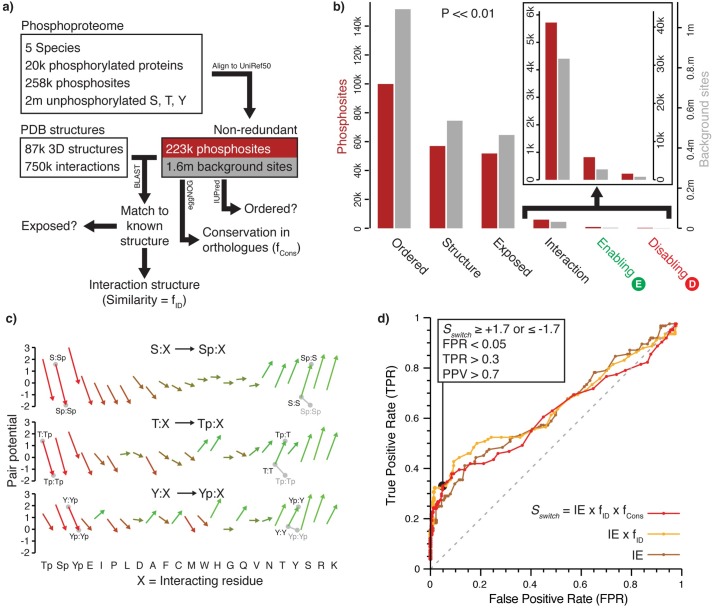
Summary of the data processing pipeline and results.a) Source data and processing steps. b) Summary of counts of phosphosites (red bars, left-hand y-axis) and background sites (grey bars, right-hand y-axis) that are ordered, matched to a template structure, were surface exposed, in an interaction interface, and predicted to be enabling or disabling by Sswitch. The left and right-hand axes are scaled to the total number of non-redundant phosphosites and background sites, respectively. The difference between the fractions of phosphosites and background sites for all categories is significant (P << 0.01). c) Change in residue interaction pair-potentials of Serine, Threonine and Tyrosine upon phosphorylation. Grey lines emphasise change in residue interaction potentials of a residue pointing at a second copy of itself across a homodimeric interface when both copies are phosphorylated. d) Receiver Operator Characteristic (ROC) curves showing the ability of Sswitch to identify enabling or disabling effects of known phosphosite switches, and the change in performance by including the interaction effect (IE, = sum of pair-potentials), similarity of the query to the structure template (fID), and the conservation of the site across orthologues (fCons). Note that the Enabling and Disabling labels in (b) are defined using the thresholds in (d).